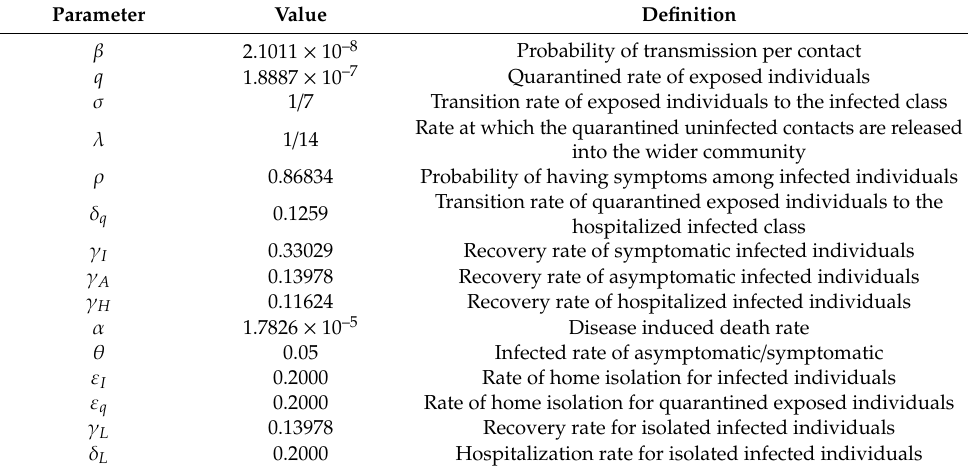
Table 1. Parameters for the extended Susceptible-Exposed-Infectious-Recovered (SEIR) model, Lombardy and